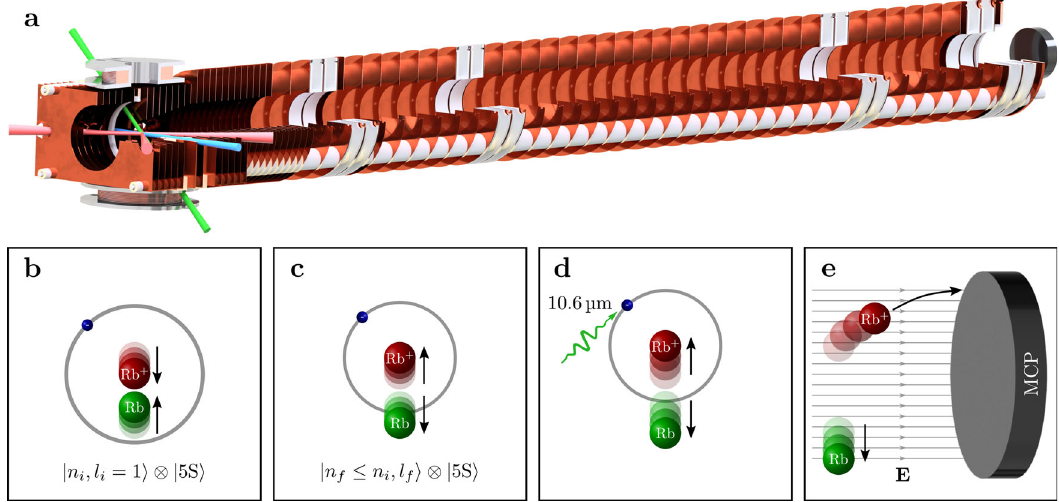
Fig. 2 Recoil-ion momentum spectrometer and experimental sequence. a CAD drawing of the experimental setup in three-quarter section view. Laser- cooled 87 Rb atoms are trapped in a crossed optical dipole trap (red beams) and excited by a three-photon transition (depicted as blue beam) to a Rydberg state. By using a high-power CO 2 laser pulse (green beam), the Rydberg atoms are photoionized ef fi ciently. The ions then follow two subsequent homogeneous electric fi elds and traverse a fi eld-free drift tube before hitting the position- and time-sensitive detector. This method allows the measurement of momentum distributions of initially neutral particles with high resolution. The lower panel shows a sketch illustrating the state-changing collision process and the experimental procedure to measure the resulting momenta. b The experiment starts with the photoassociation of an ULRM, (cid:1) (cid:3) (cid:1) where the initial state of the Rydberg electron (blue) is n i ; l i ¼ 1 . Subsequently, the Rydberg core (red) and the neutral atom (green) approach each other. c During the inelastic collision, the Rydberg electron changes its state ( fi nal principal quantum number n f is less than or equal to n i ). The fi nal angular momentum quantum number l f may be any value between 0 and ( n f − 1). The release energy is apportioned equally between the Rydberg atom and the perturber atom, which fl y into opposite directions due to the momentum conservation. d The Rydberg atom is photoionized by a CO 2 laser pulse. e Electric fi elds guide the ionic core toward the detector without changing the transverse momentum. From the point of impact the momentum of the Rydberg atom can be